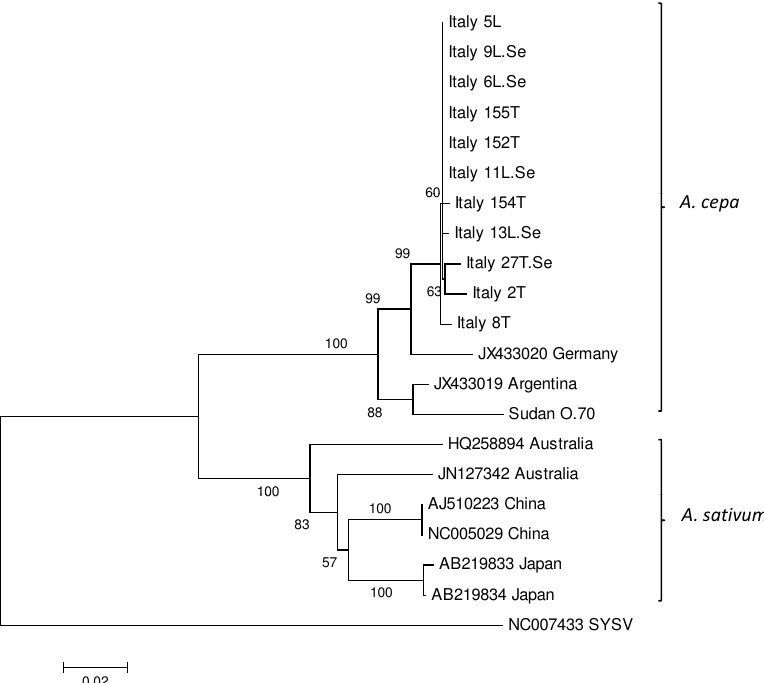
Figure 3. Neighbour-joining tree based on multiple alignment of complete NIb protein sequences of OYDV between Italian and Sudanese isolates from this study, German and Argentine isolates from onion and isolates from garlic available from the database. The sequence of SYSV (NC007433) was used as an out-group. Bootstrap percentages of clades, reported along the branches of the tree with value >50%, derived from bootstrap-resampled data sets (1000